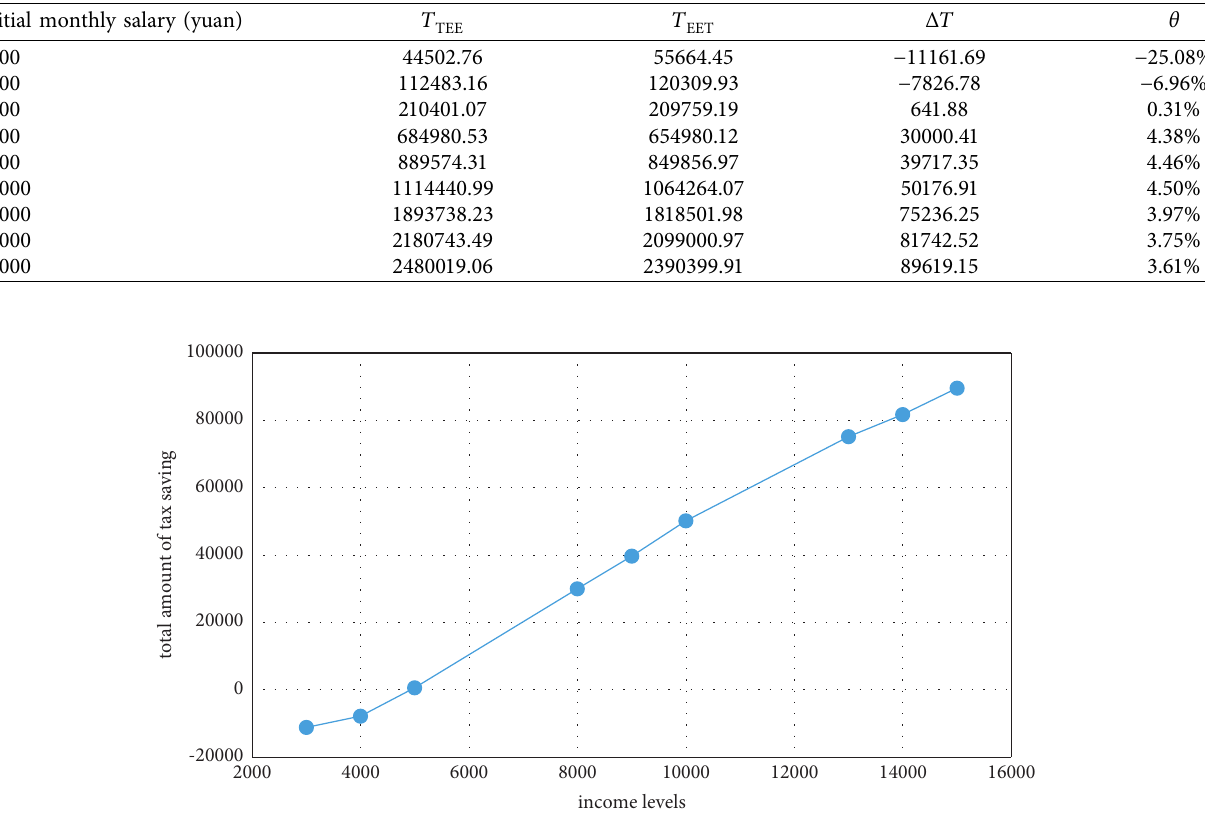
Table 1: Tax difference and tax-saving rate under TEE mode and EET mode under different income levels.